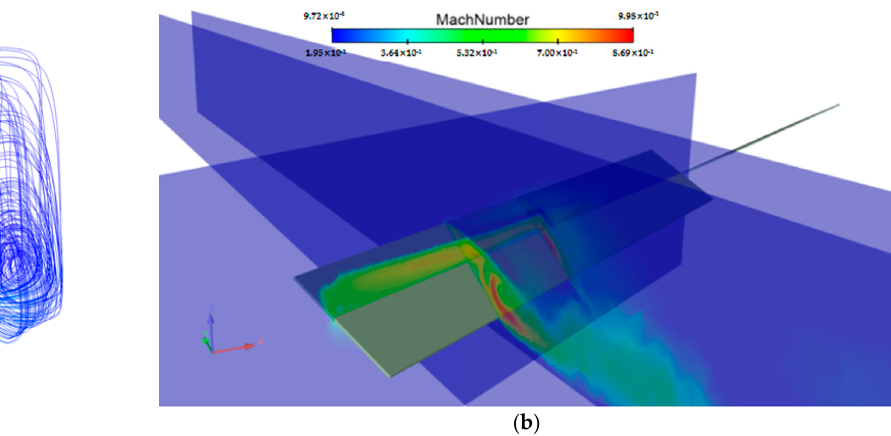
Figure 8. Streamline ( a ) and slice Mach number contours ( b ) of the flow field of case 2.